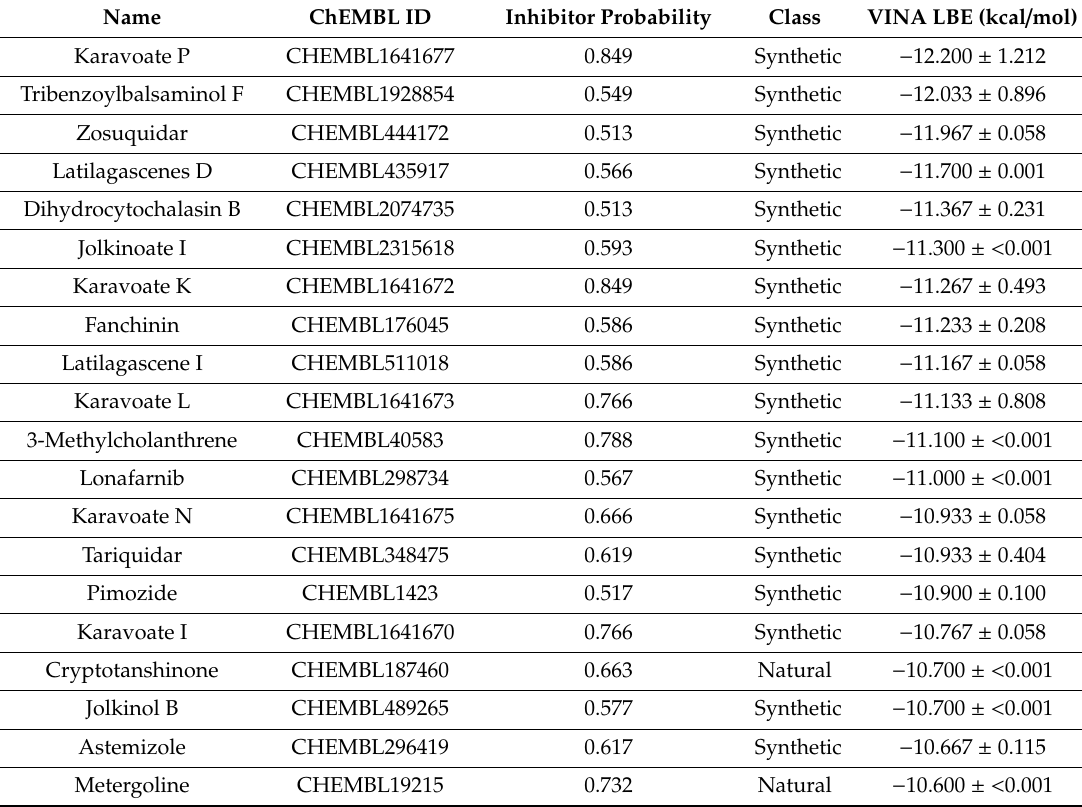
Table 6. Prediction of the top 20 P-gp inhibitors identified by the RF classification algorithm using the ChEMBL P-gp modulator list of 493 compounds. The results were validated by determining the binding a ffi nities using Autodock VINA.